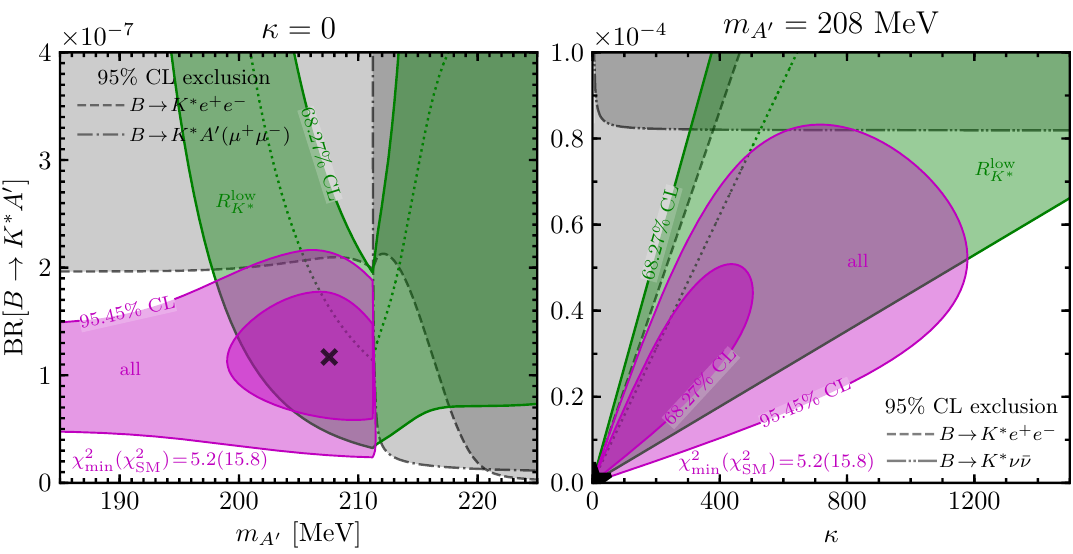
Figure 1 . Preferred regions of parameter space for a dark-photon explanation of the low- q 2 bin of R K (cid:3) . In magenta the preferred region including all constraints (see main text) and in green the preferred region from the measurement of the low- q 2 bin of R K (cid:3) alone. In grey the 95% CL exclusion regions from the measurements listed in the legend. In the left plot,